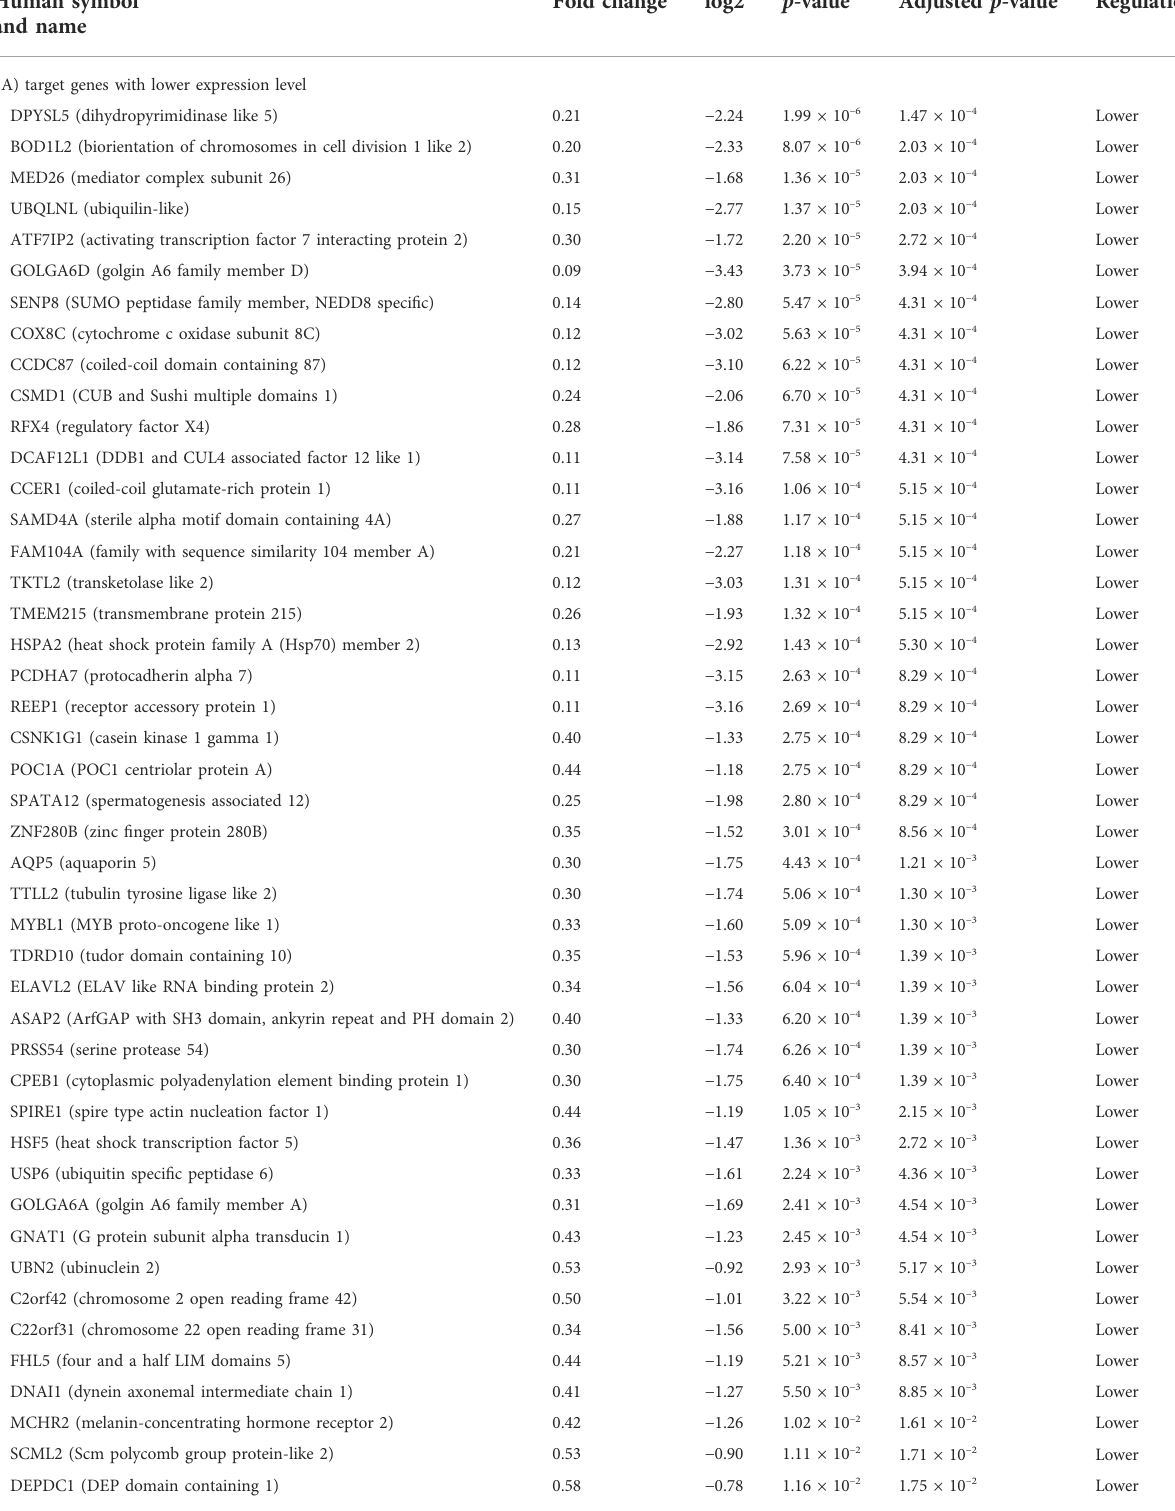
TABLE 2 Signi fi cantly abundant levels of mRNAs in the sperm samples collected from men with oligoasthenozoospermia compared to men with normozoospermia as determined by